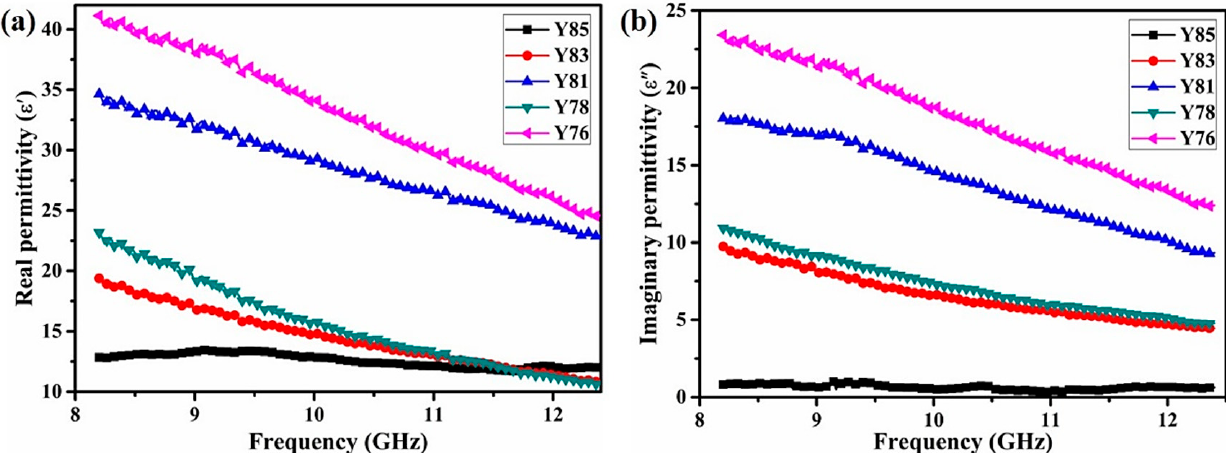
Figure 3. The ( a ) ε′ and ( b ) ε″ plots of the plasma-sprayed Y 2 O 3 /ZrB 2 /CNT hybrids in the full X-band.